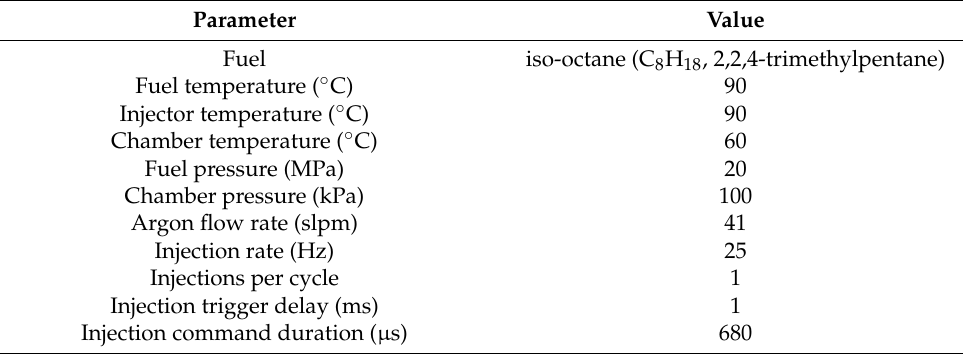
Table A1. Spray chamber and injector operating